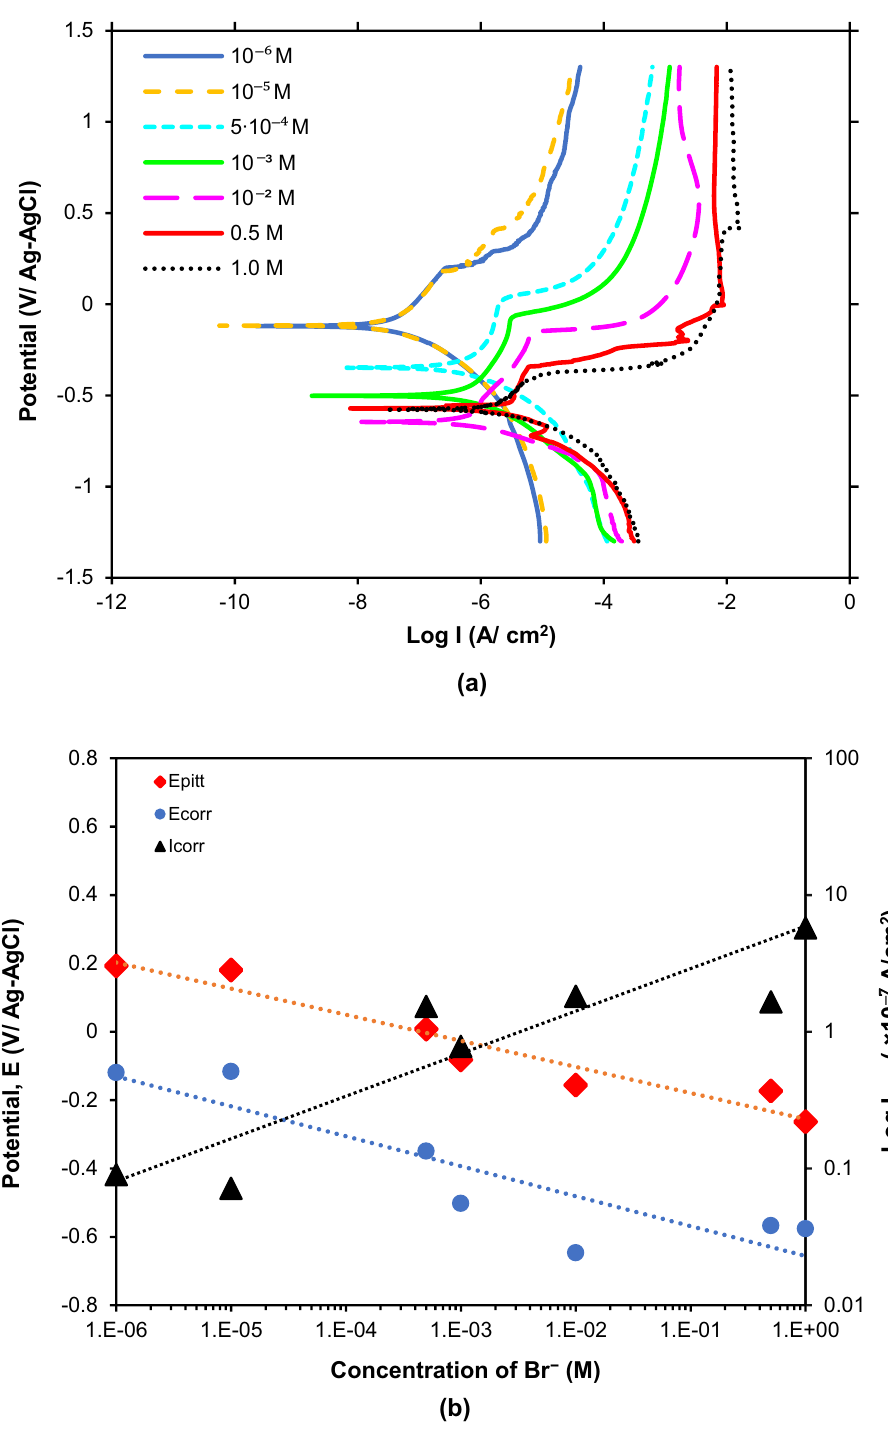
Figure 7. ( a ) Polarization curves of Sn in various Br − concentrations. ( b ) Comparison of the electrochemical properties of pure tin in various Br −